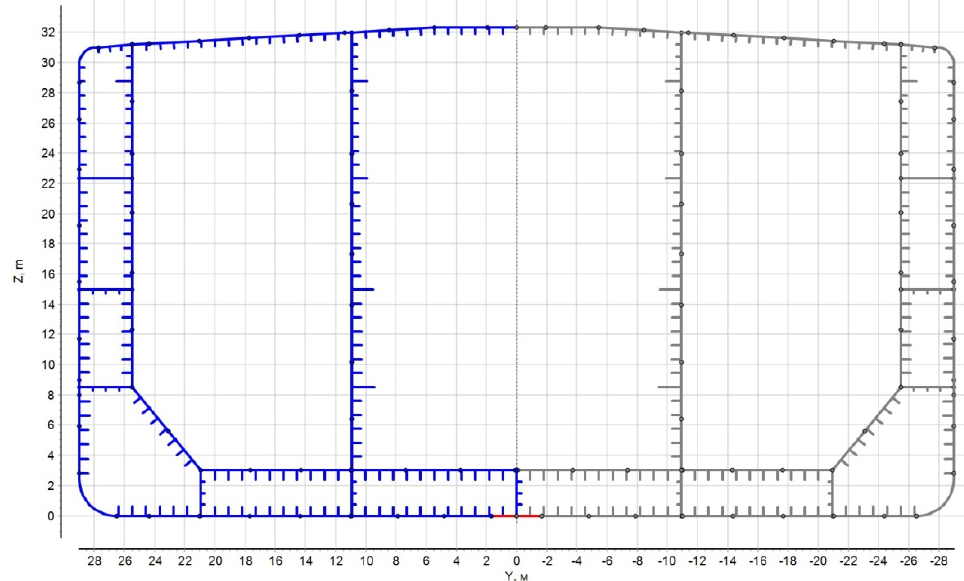
Figure 6. Structural modeling of the ship hull cross-section (first mode).